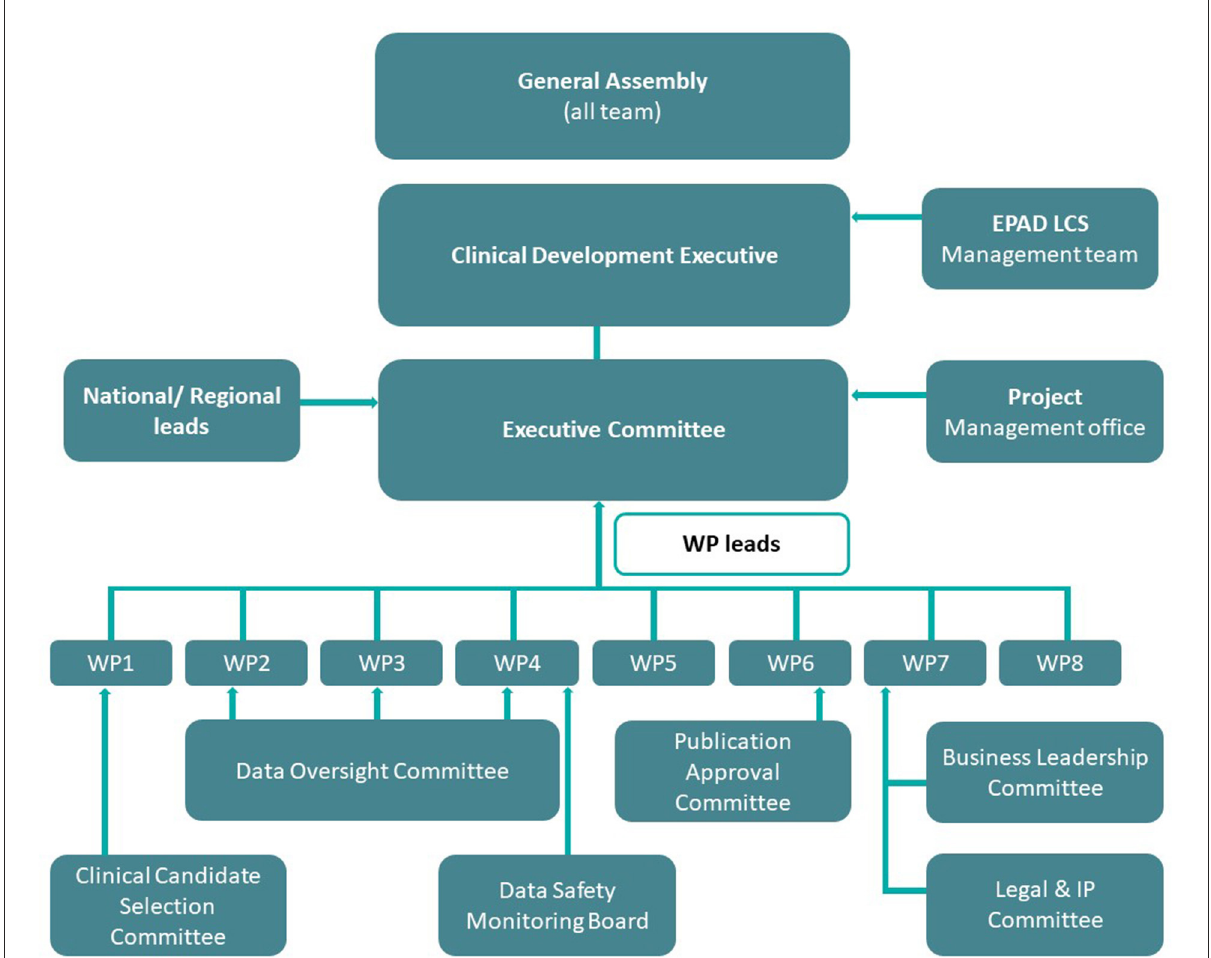
FIGURE1 EPAD governance structure. Work Package 1: Scientific Challenges; Work Package 2: Statistical/Methodology Engine Room; Work Package 3: Parent Cohorts and EPAD Register; Work Package 4: EPAD Cohort and EPAD Trials; Work Package 5: Project Management; Work Package 6: Dissemination; Work Package 7: Business Model and Sustainability; Work Package 8: Ethical, Legal and Social